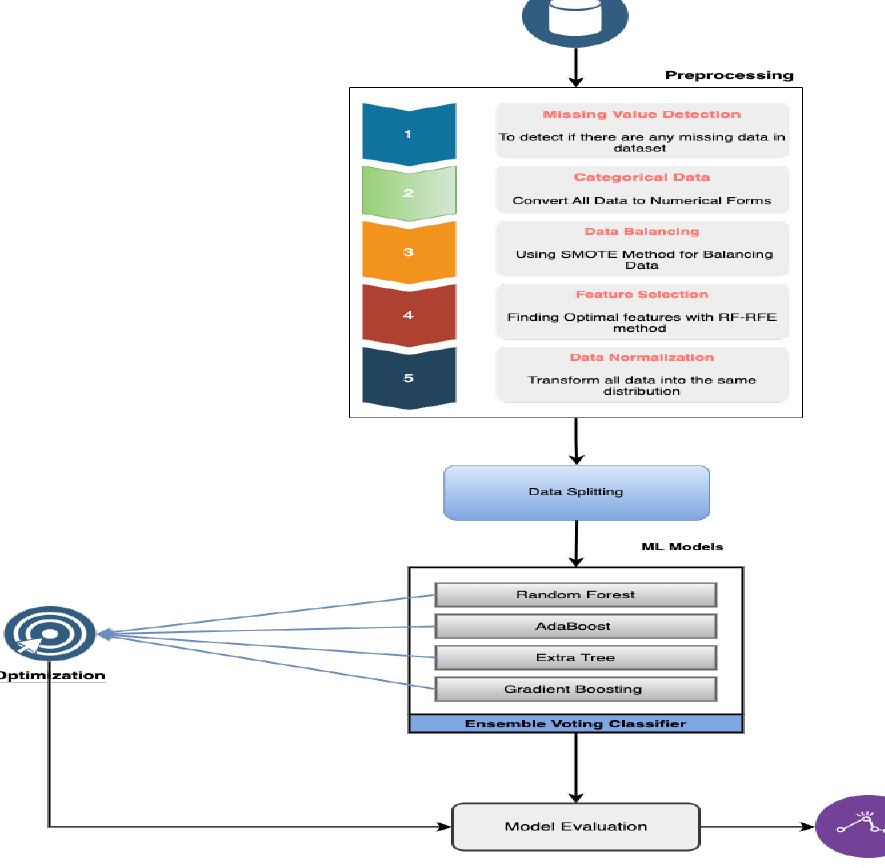
Figure 1. Flowchart for our proposed